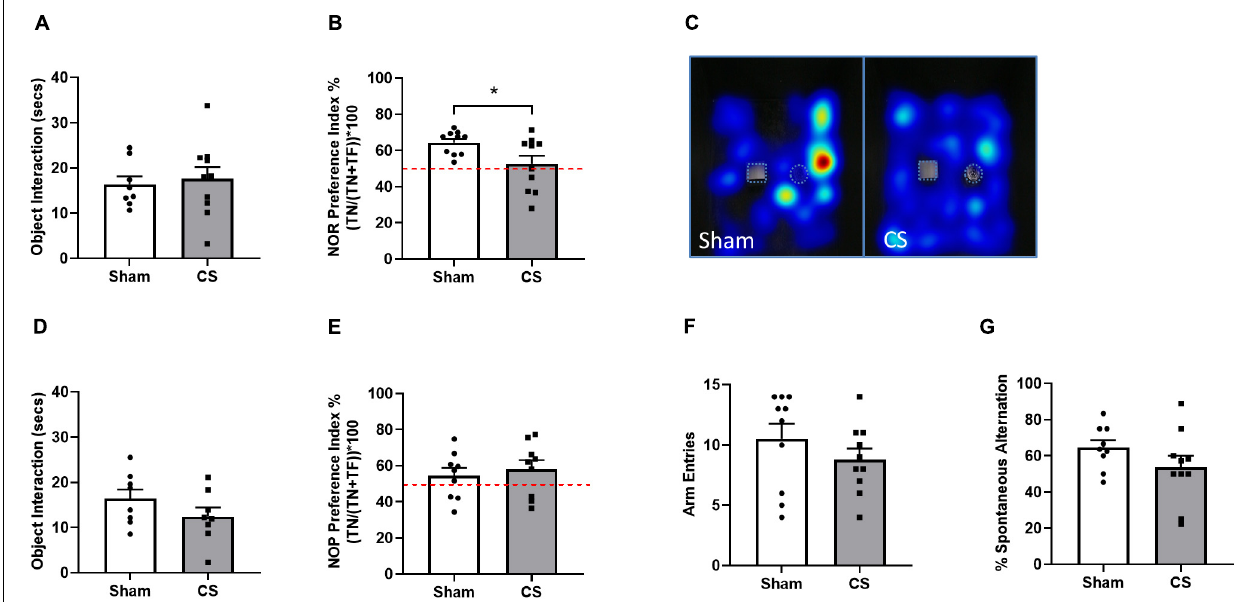
FIGURE 4 | Chronic CS exposure decreased working memory in mice. Behavioral testing was performed on mice 1 week prior to protocol conclusion. (A) Total exploration time (seconds) in novel object recognition (NOR) acquisition phase. (B) NOR Preference Index. (C) Representative heatmaps illustrating familiar object (square) and novel object (circle) exploration in the NOR. (D) Total exploration time (seconds) in novel object placement (NOP) acquisition phase. (E) NOP Preference Index. (F) Arm entries in the Y Maze. (G) Percentage spontaneous alternation in Y Maze. Red dotted line in (B,E) represents a Preference Index of 50%. Data was analyzed by Student’s t -test and expressed as mean + SEM with significance being represented as * p < 0.05. n = 10 for the NOR and NOP and n = 14 for Y maze.